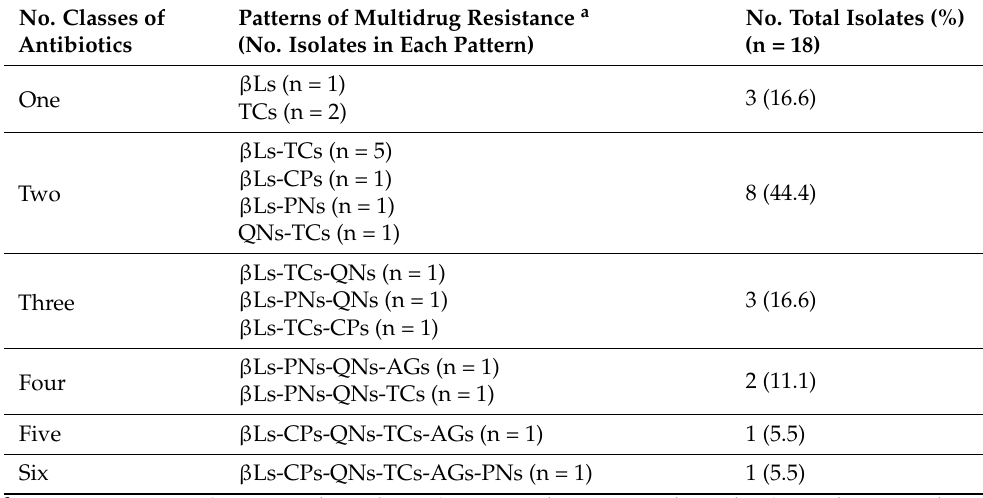
Table 2. Patterns of multidrug resistance classes of the C. perfringens isolates from the raw meat samples. No. Classes